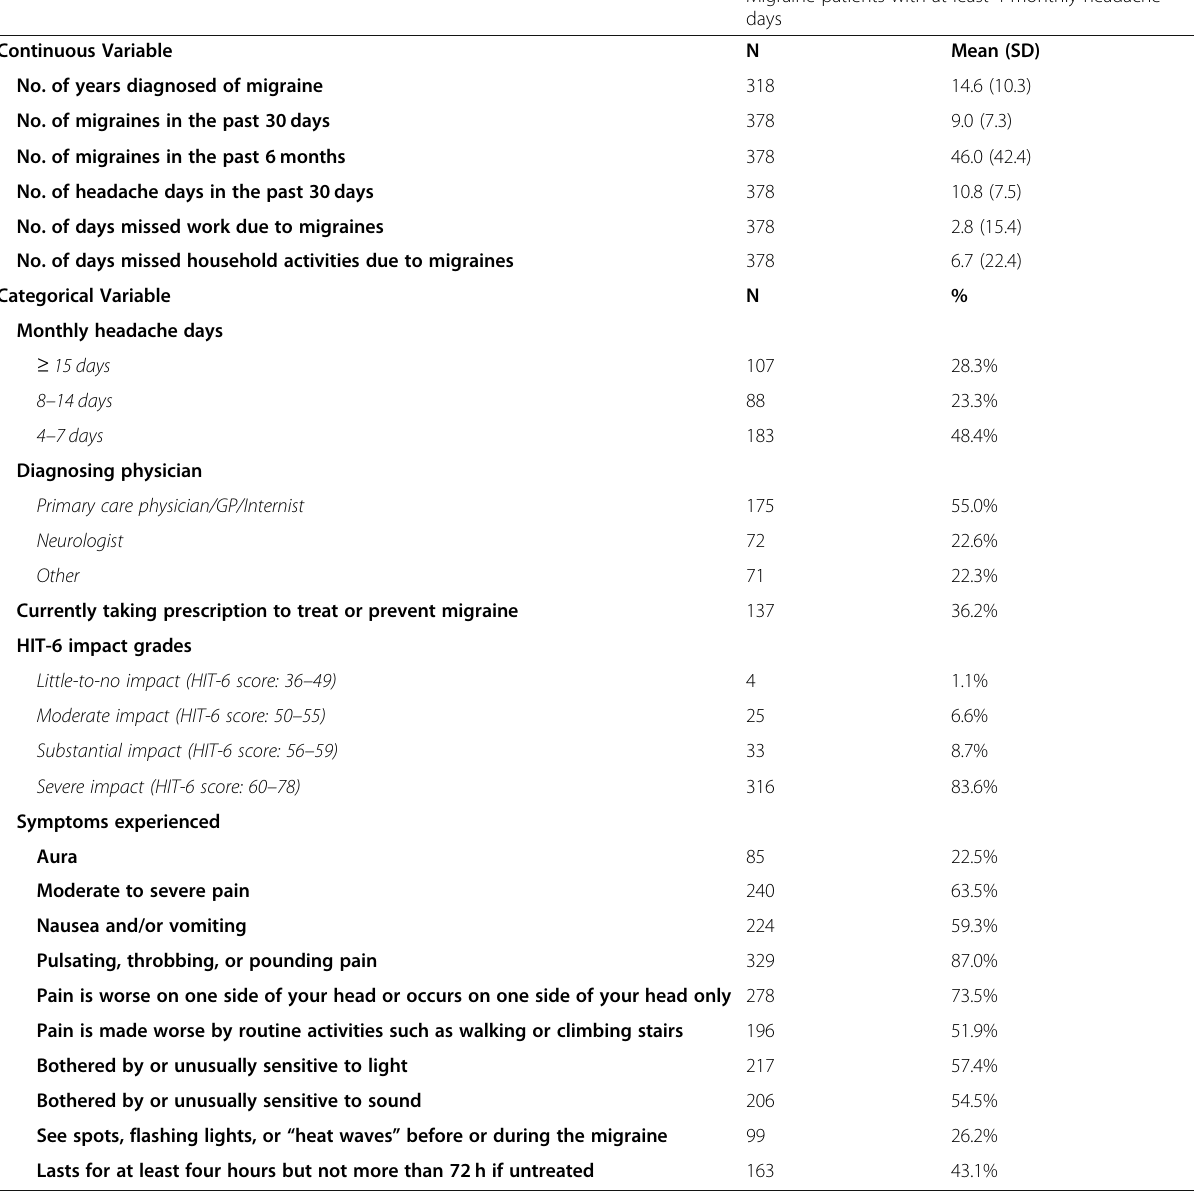
Table 1 Self-reported migraine-related health characteristics among migraine patients